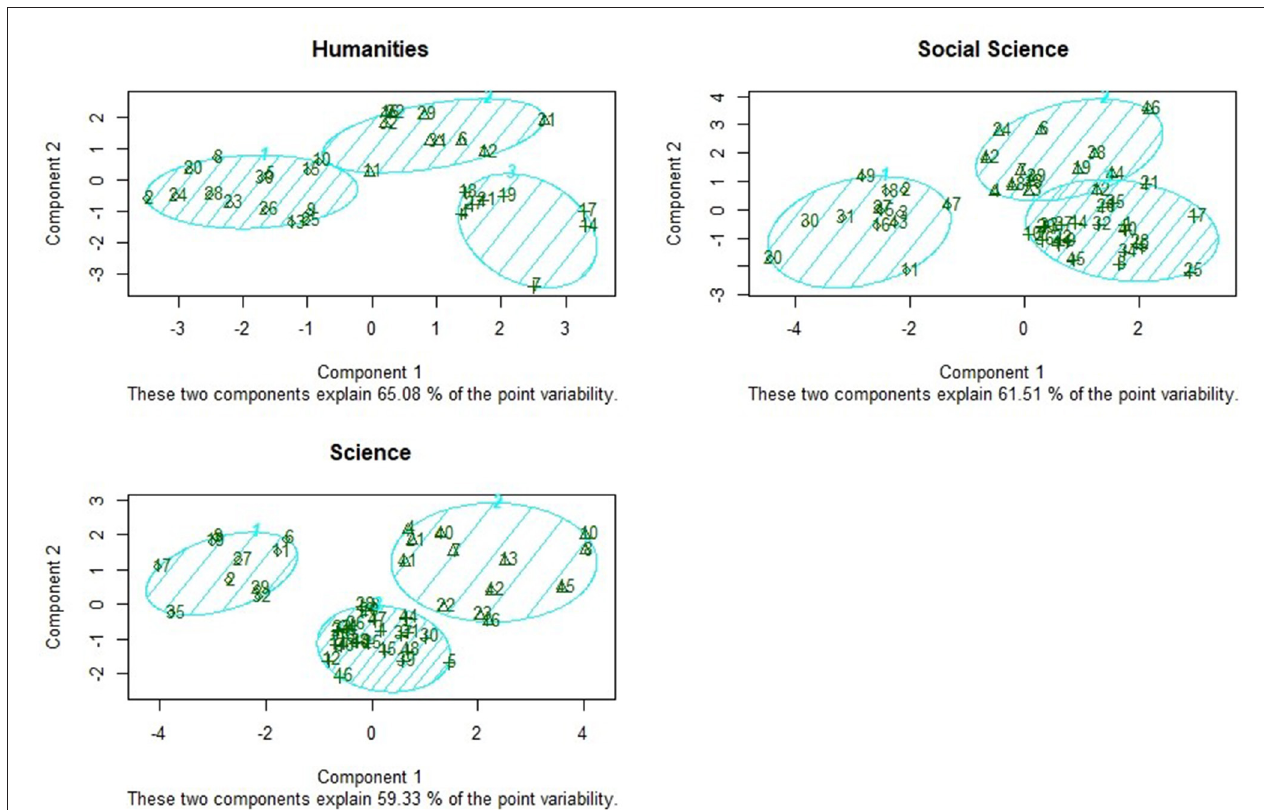
FIGURE 2 | Two-dimensional representation of clusters.